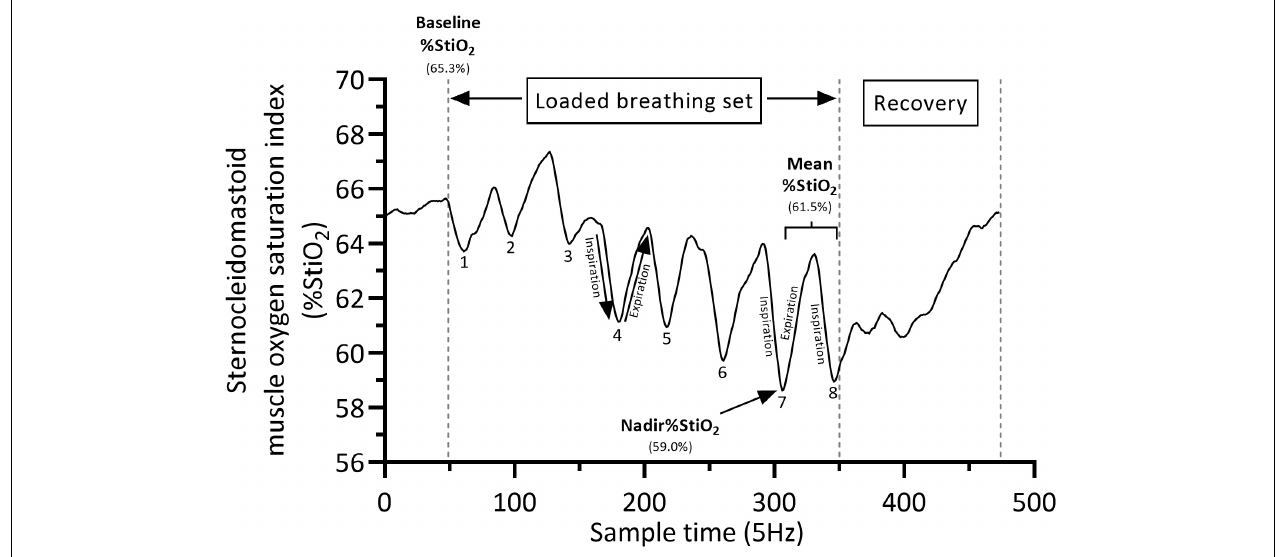
FIGURE 2 | Typical calculation of muscle oxygen saturation index (%StiO 2 ) during a loaded breathing set. Baseline %StiO 2 (defined as the average of the last 10 s before the initiation of each breathing set), Mean %StiO 2 (defined as the average of the last two breaths of each set) and Nadir %StiO 2 (defined as the lowest value recorded during the last two breaths of each set). Numbers (from 1 to 8) represent the number of breaths of the set. %StiO 2 data depict the sternocleidomastoid muscle. %StiO2 changes from baseline are calculated as follow: Mean-Baseline = − 3.8% and Nadir– Baseline = −